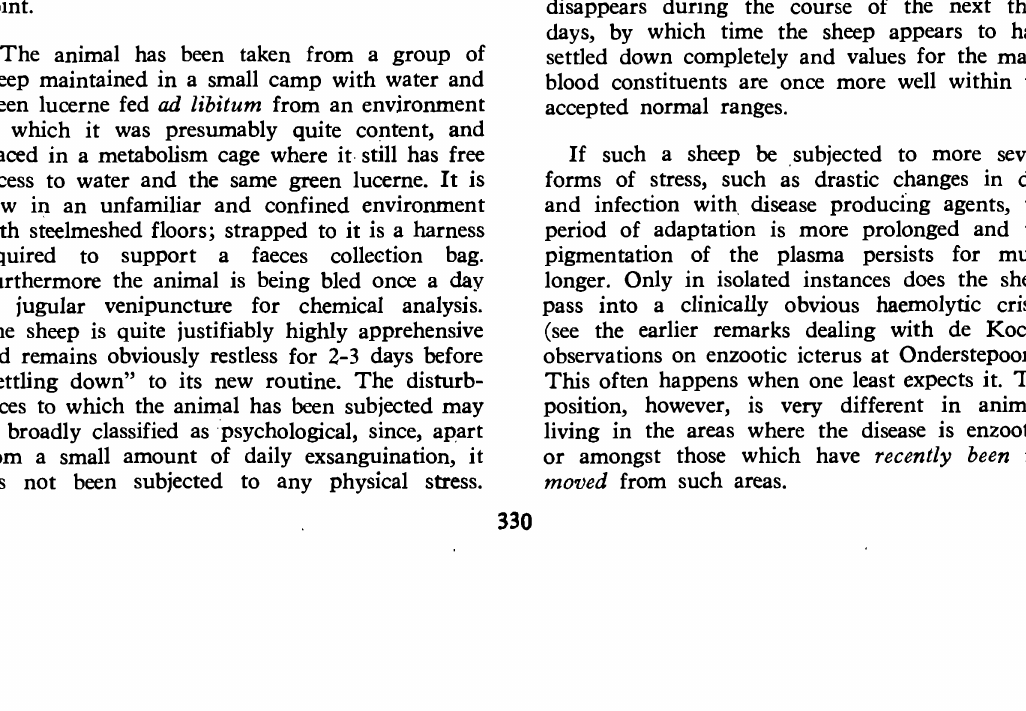
TABLE 3.- MONTHLY VARIATIONS IN RAINFALL AT BASTERSBERG, SUTHERLAND DURING THE SPRING AND SUMMER OF 1957- 1958 (GIVEN IN MILLIMETRES.)